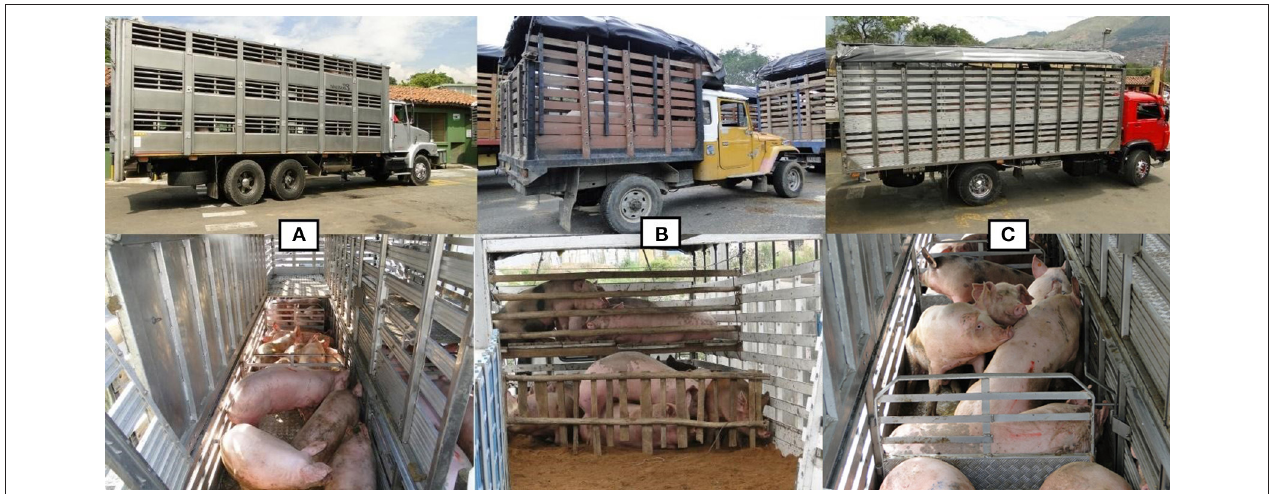
FIGURE 1 | Types of trucks surveyed in this study: (A) Specialized triple-deck truck (Slaughterhouse A ), (B) single-deck and non-specialized truck (slaughterhouse B ) and (C) specialized double-deck truck (slaughterhouse C